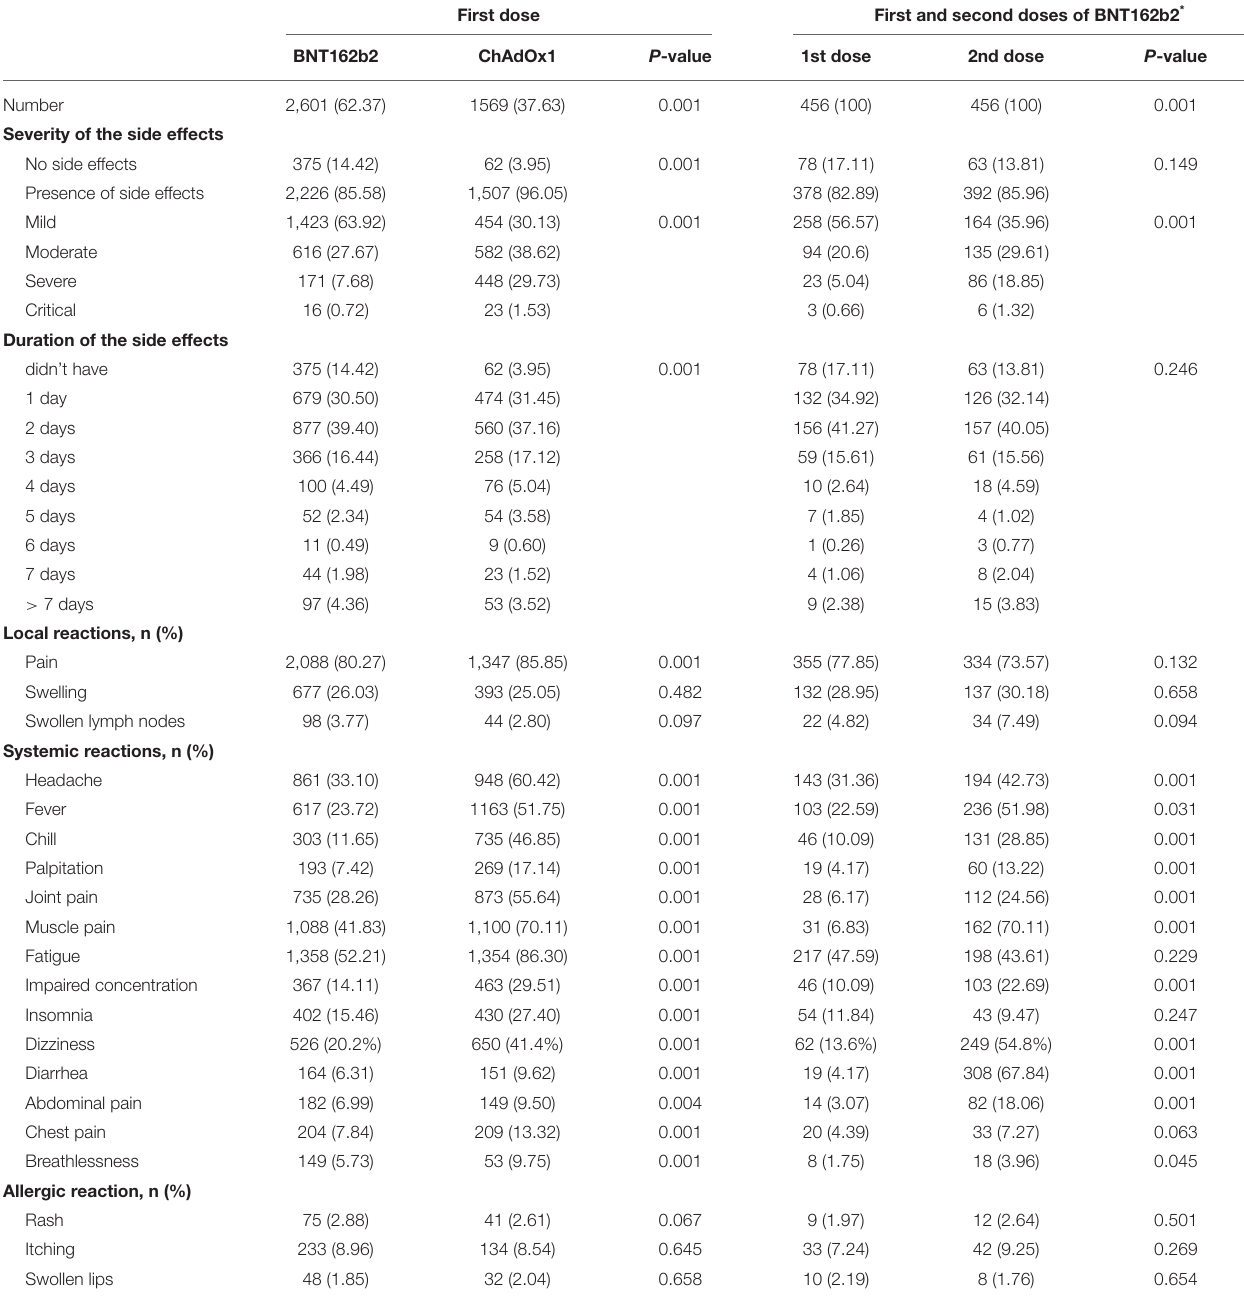
TABLE 4 | Comparison between the post vaccine adverse effects after vaccination with BNT162b2 and ChAdOx1 as well as those after the first and the second doses of